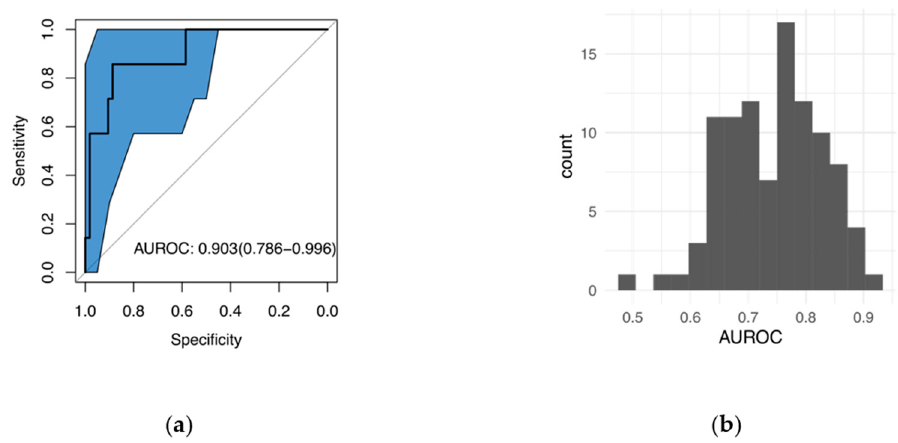
Figure 1. ( a ) Receiver operating characteristic (ROC) curve for classifying melanoma vs. pigmented lesions. The area under the ROC curve (AUROC) of 0.903 means high accuracy in distinguishing melanoma from pigmented lesions. The blue shade shows the 95% confidence interval for the ROC. ( b ) The histogram of AUROC from 99 randomization tests, where 7 out of 60 lesions were randomly assigned to the “melanoma” group. There is only a small chance (1%) that the observed AUROC is greater than 0.9 for the randomization tests, which suggests that the high AUROC is mostly likely due to real differences between melanoma and pigmented lesions.